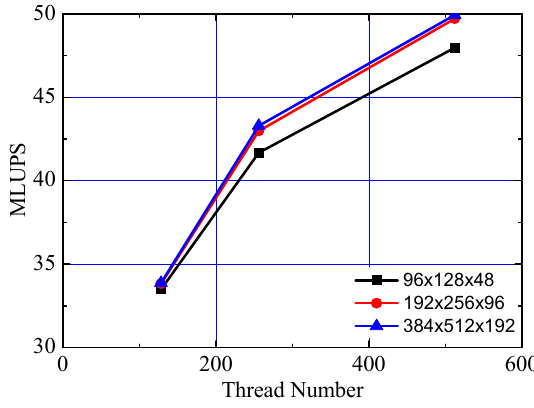
Figure A2. MLUPS of a GPU with different thread number.